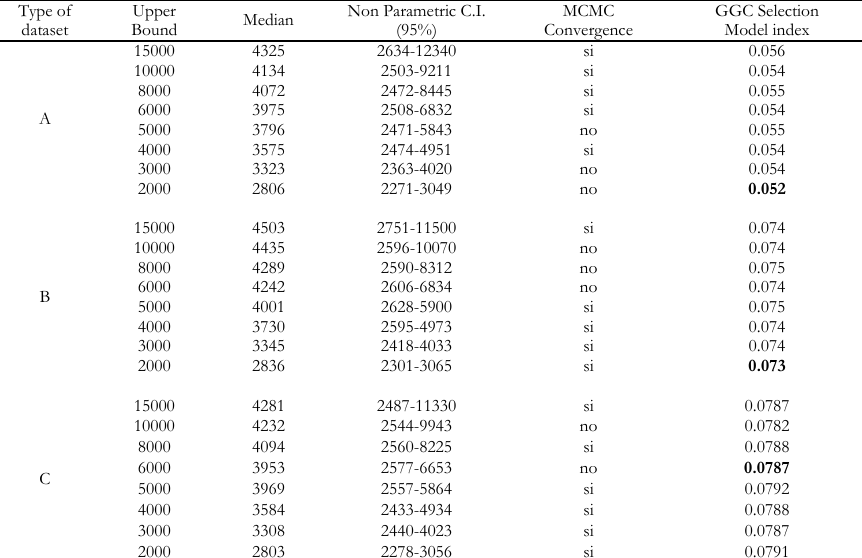
Bayesian estimated population size and Non Parametric C.I. according to the a priori upper bound (Bayesian Capture-Recapture